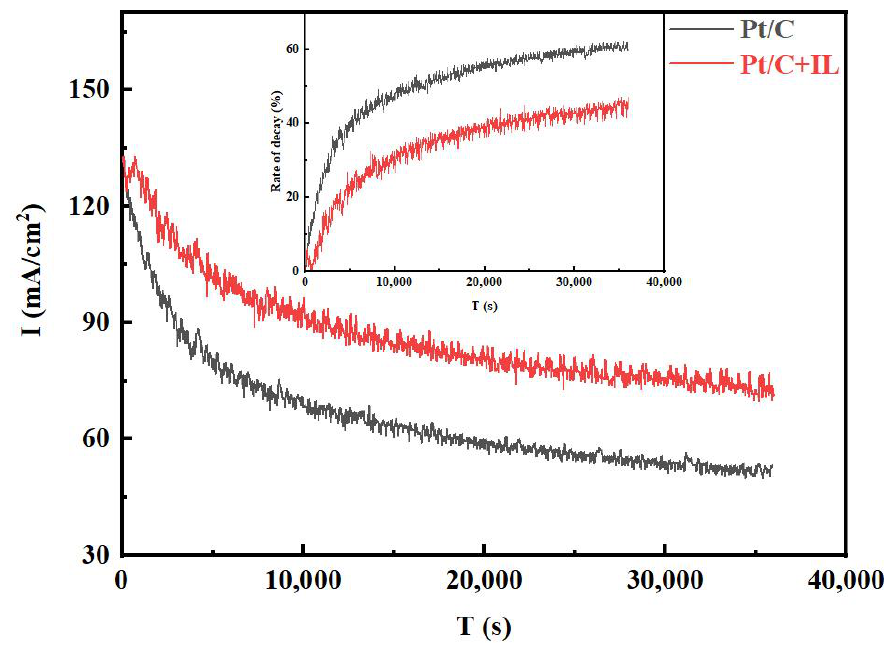
Figure 2. The I – t curves for Pt/C and Pt/C + IL (0.85 V, 10 h). Figure 2. The I–t curves for Pt/C and Pt/C + IL (0.85 V, 10